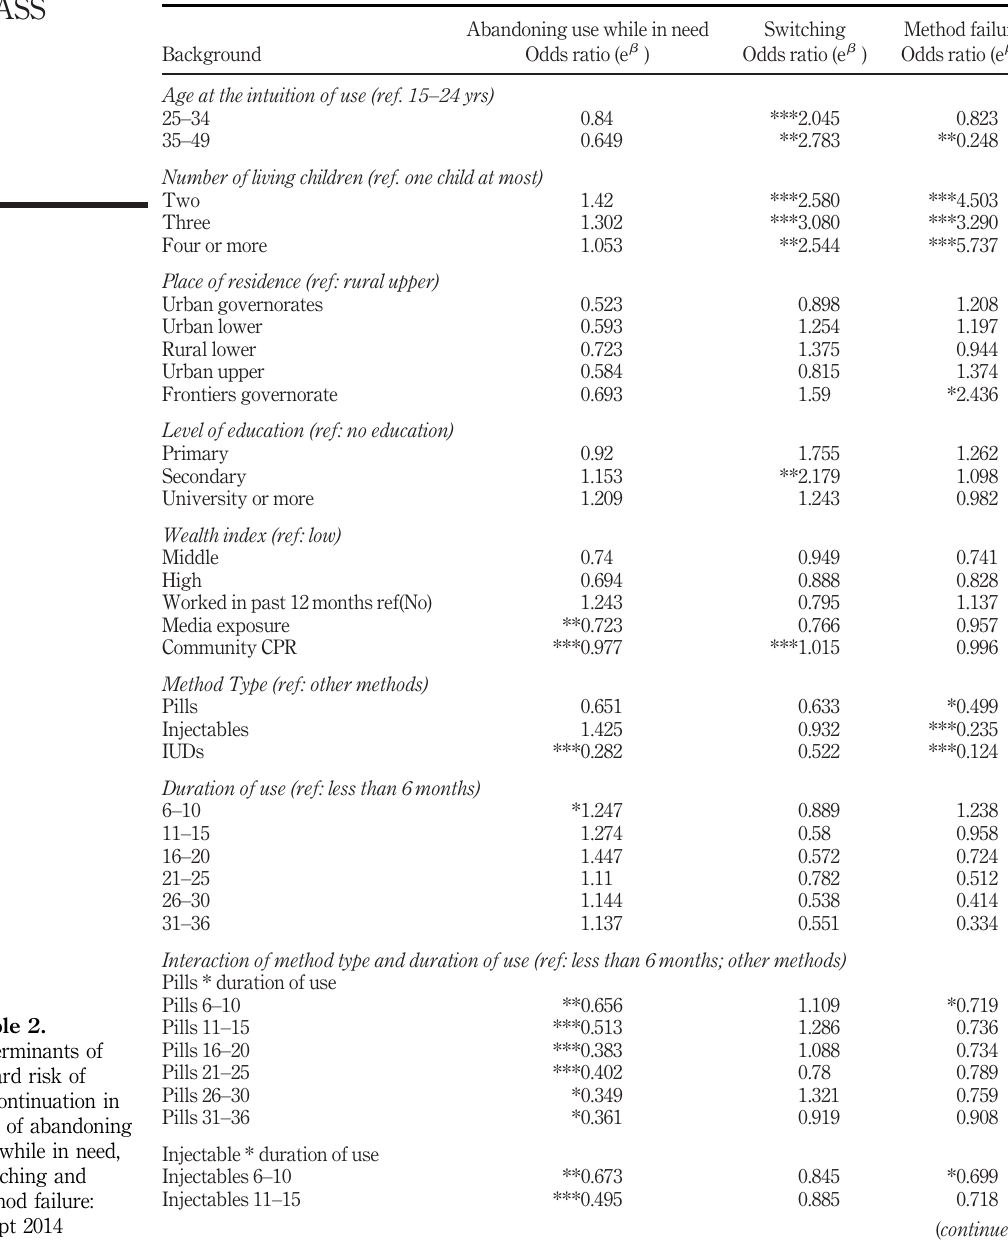
Table 2. Determinants of hazard risk of discontinuation